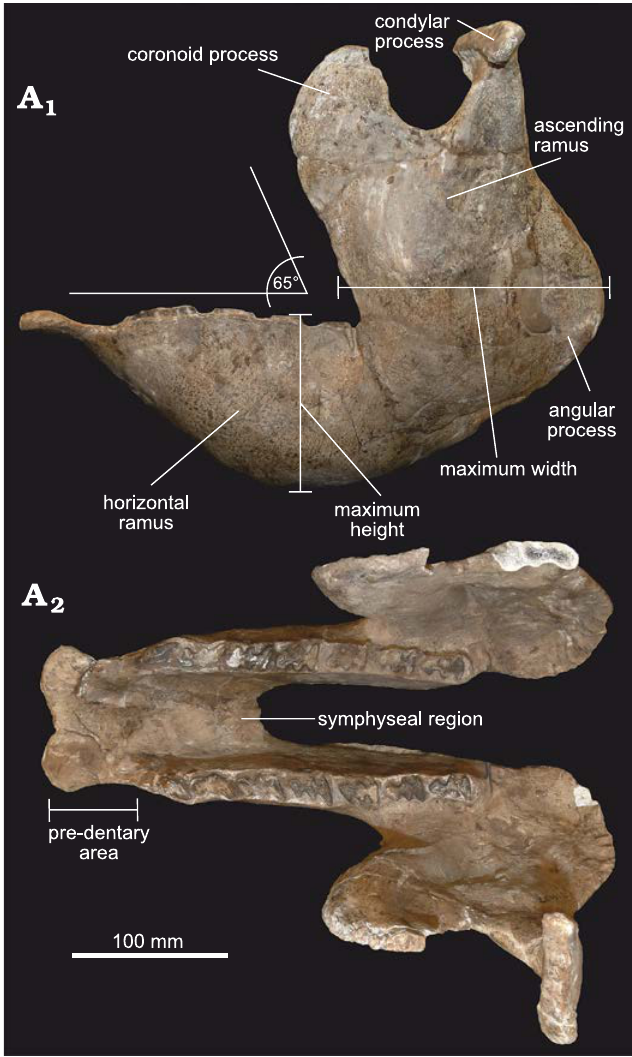
Fig. 5. Mandible of doedicurine glyptodont Eleutherocercus solidus (Rove- reto, 1914), FMNH-P 14437, from, upper Miocene–Pliocene, Puerta de Corral Quemado, Andalhuala Formation, levels 23–28, Argentina; in left lateral external (A 1 ), and occlusal (A 2 )